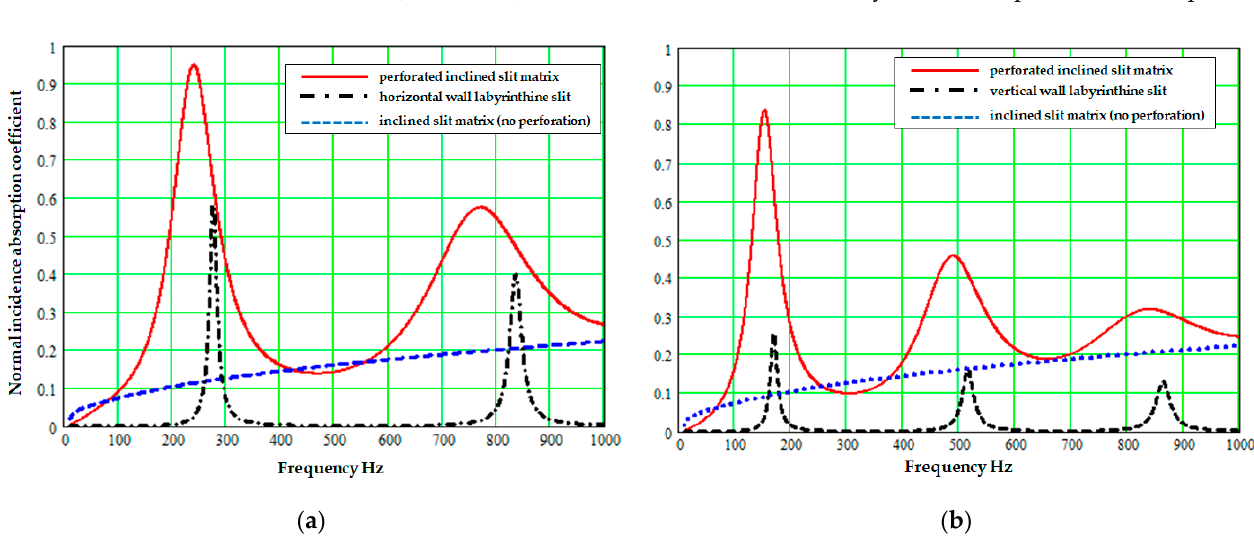
Figure 3. Normal incidence absorption spectra predicted for 5.8 cm thick hard ‐ backed porous lay ‐ ers of rockwool and melamine foam described by the JCAL parameters listed in Table 1 with hori ‐ zontal ‐ wall labyrinthine slit perforations ( 𝑤 = 5 mm, 𝑏 = 5.5 mm, 𝑙 = 40 mm, 𝑁 = 5 as shown on the right). Also shown (dash dot lines) are predictions for these materials without perforation.